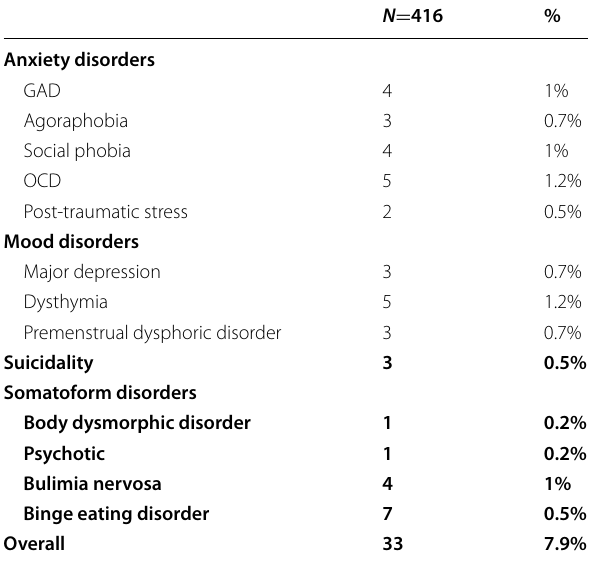
Table 2 Frequency of psychiatric disorders among the studied